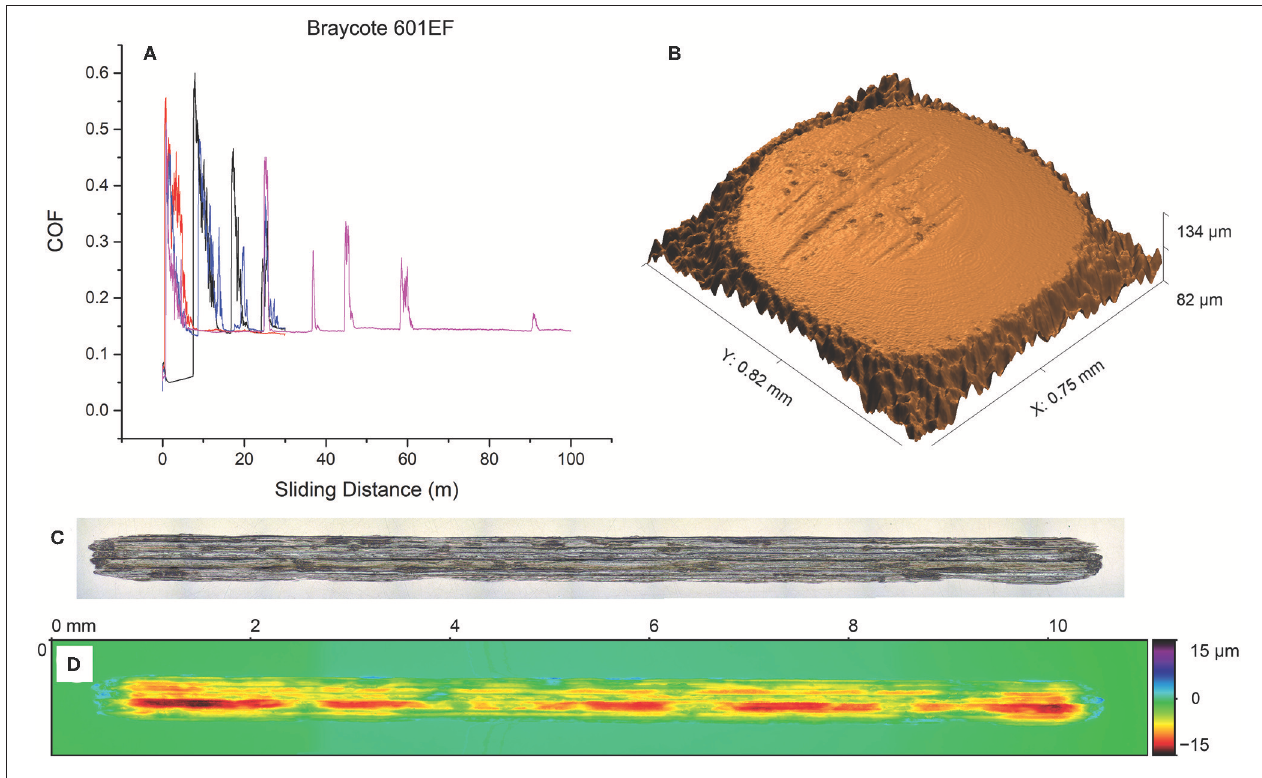
FIGURE 3 | Test results for Braycote 601EF including (A) friction traces, (B) interferometer image of the ball wear scar, and (C,D) optical microscope and interferometer images of the flat wear scar. All wear images correspond to the test shown in blue in (A)